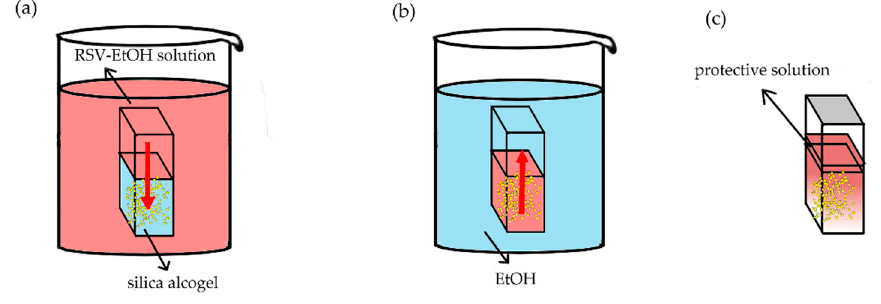
Figure8. Theschematicdiagramof: ( a )inwarddi ff usion, ( b )outwarddi ff usionand( c )internaldi ff